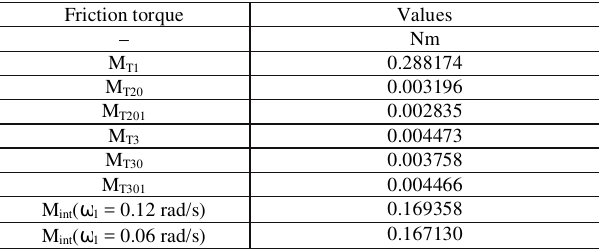
Table 2. Calculated values of friction torque in bearings and internal friction torque in the chain transmission Friction